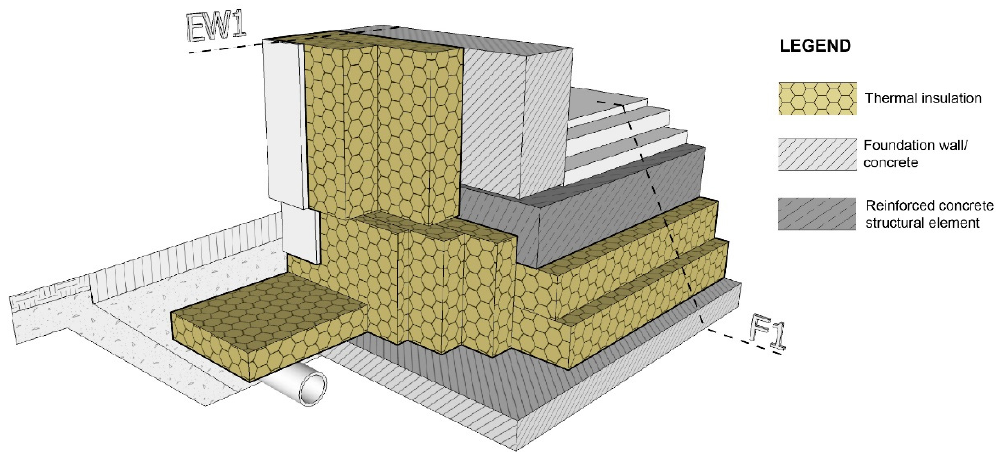
Figure 8. Detail of the joint of the slab-on-ground foundation and external wall. Layers: (i) EW1—external wall (ii) F1—floor on the-described in Section 3.2.